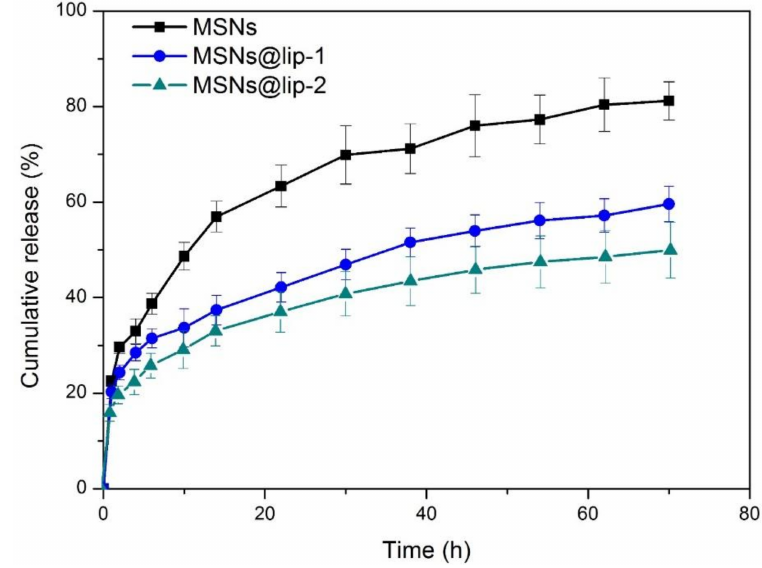
Figure 5. The release profiles of RhB-loaded MSNs, MSNs@lip-1 and MSNs@lip-2 in PBS (pH 7.4) at 37 ◦ C.